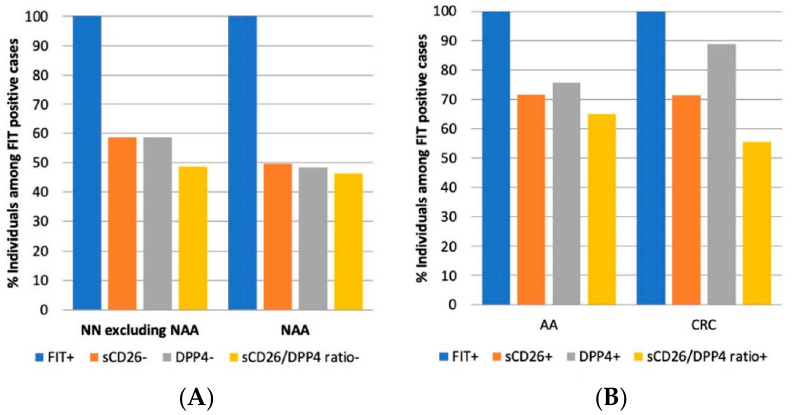
Figure 1. Frequencies of positive and negative cases from the blood test among FIT positives with no neoplasia ( A ) and advanced neoplasia ( B ). ( A ), proportion of negative cases for sCD26, DDP4 and sCD26/DDP4 among FIT positives with no neoplasia; ( B ), proportion of positive cases for sCD26, DDP4 and sCD26/DDP4 ratio among FIT positives with advanced neoplasia.